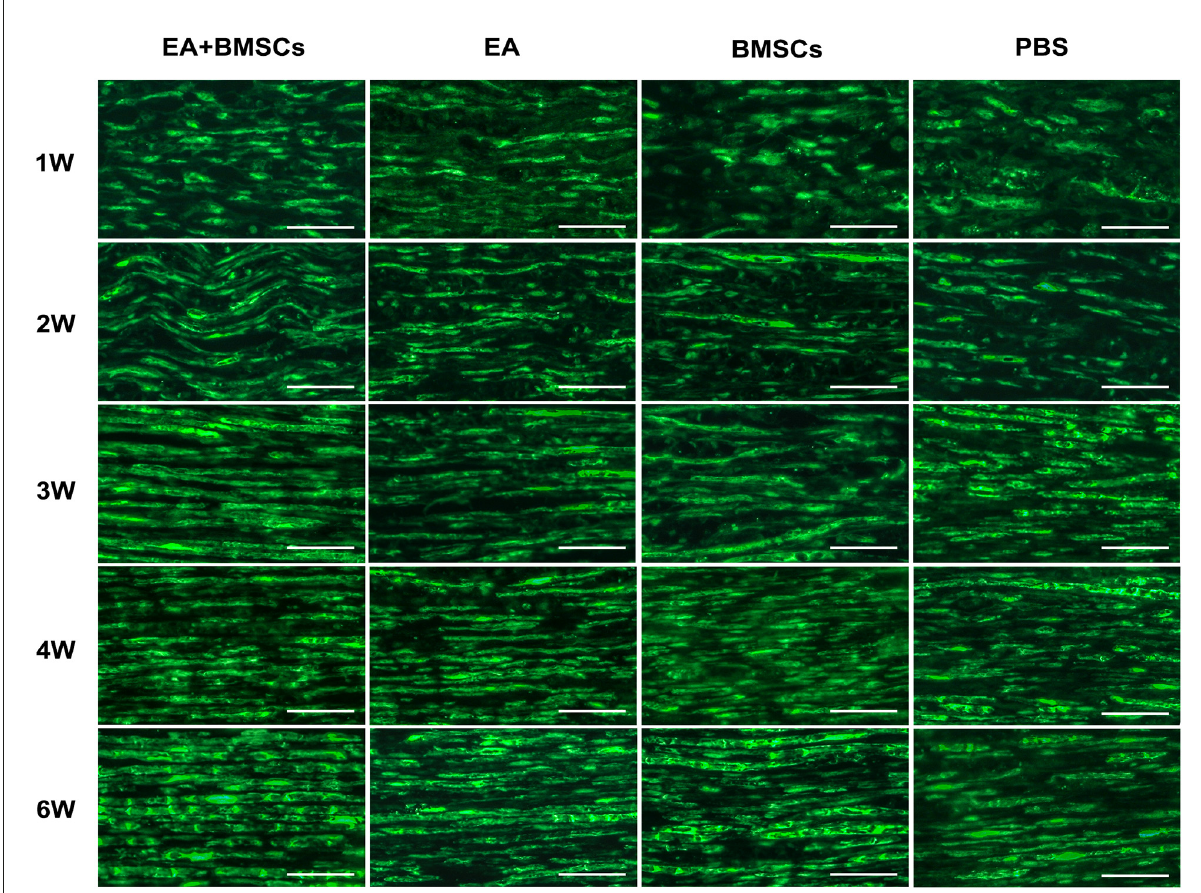
FIGURE7 S100 staining of the distal stumps of injured nerves. Immunohistochemical staining of S100 observed under the fluorescence microscope (400 × ) showed the continuity of the restored, damaged sciatic nerve. In terms of neural regeneration connections, compared with the PBS subgroup, the EA + BMSCs subgroup recovered best. In addition, the EA subgroup was better than the BMSC subgroup. Scale bar = 50 µ m; W: